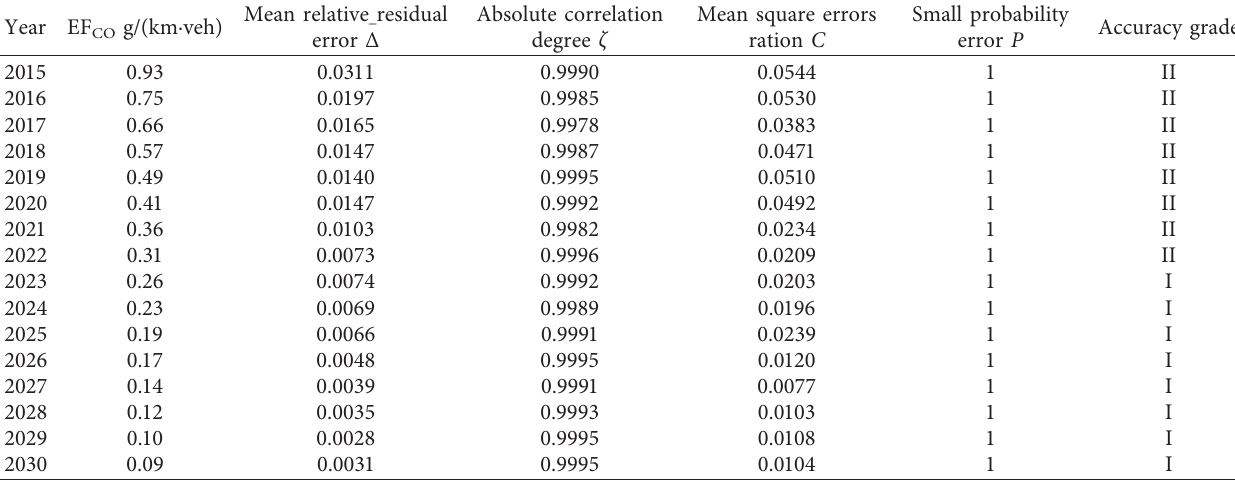
Table 3: The prediction and accuracy check results of passenger cars during 2015 ∼ 2030 in